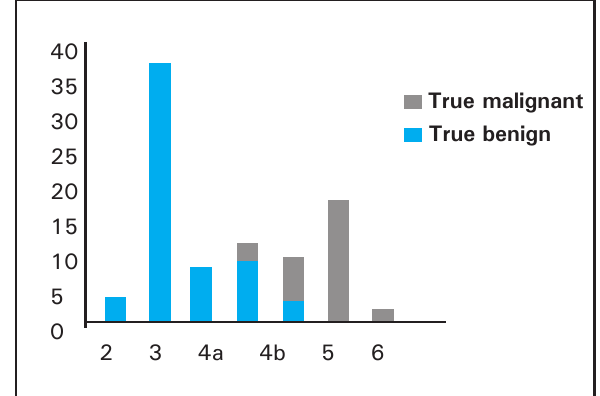
Figure 1. BIRADS category distribution of the